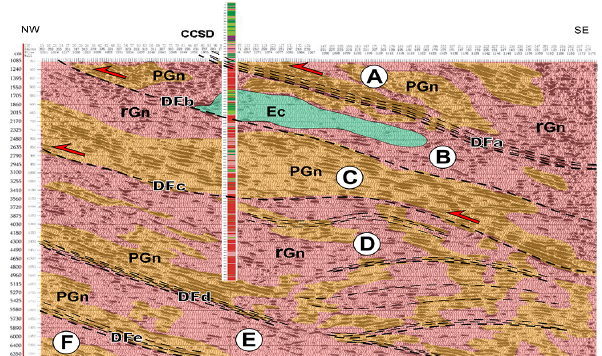
Figure 5. Interpretation of seismic reflection profile across the CCSD-MH (Xu et al., 2009a). A, B, C, D, E and F represent slices of UHP rocks. Ductile shear zones (DFa, DFb, DFc, DFd, and DFe) are recognized according to lithological/ structural profiles and re- flectivity. Ec: eclogite; PGn: paragneiss; rGn: granitic